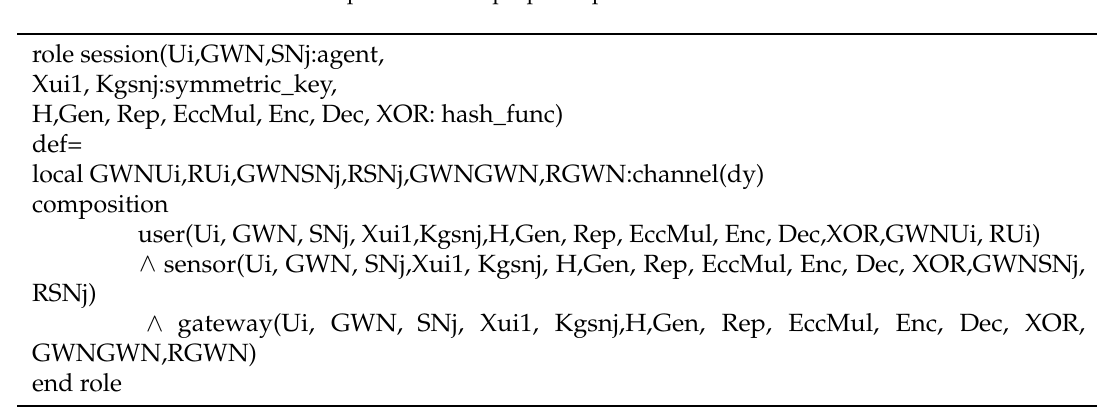
Table 17. Specification of proposed protocol’s session in HLPSL.